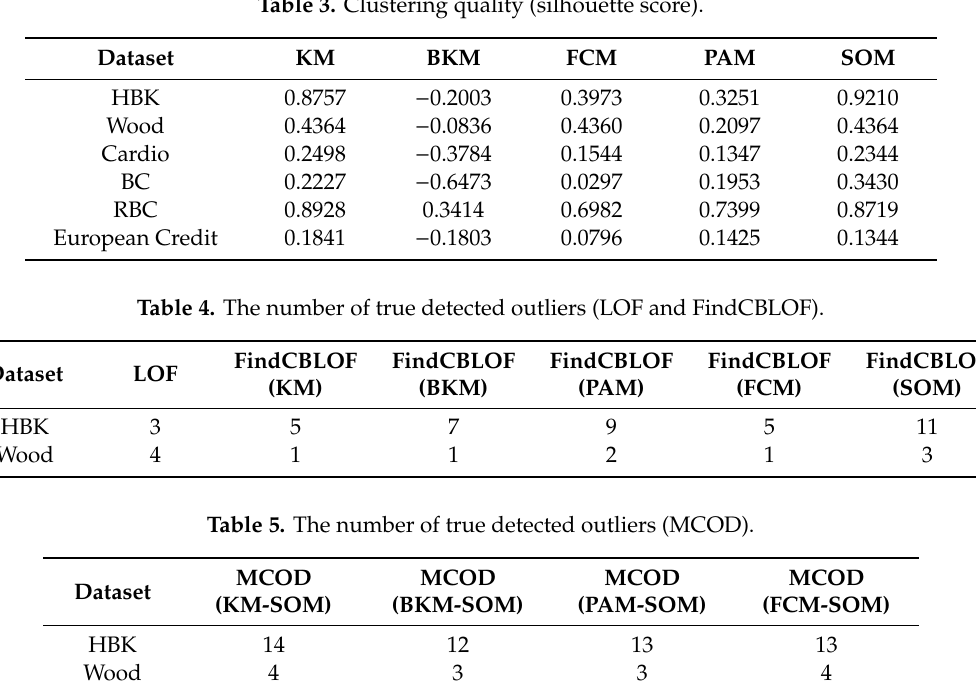
Table 3. Clustering quality (silhouette score).